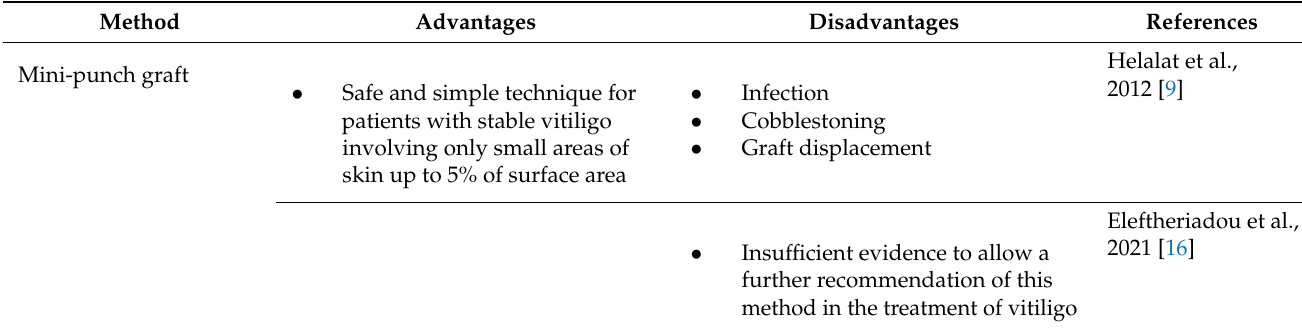
Table 2. Comparison of advantages and disadvantages of different surgical